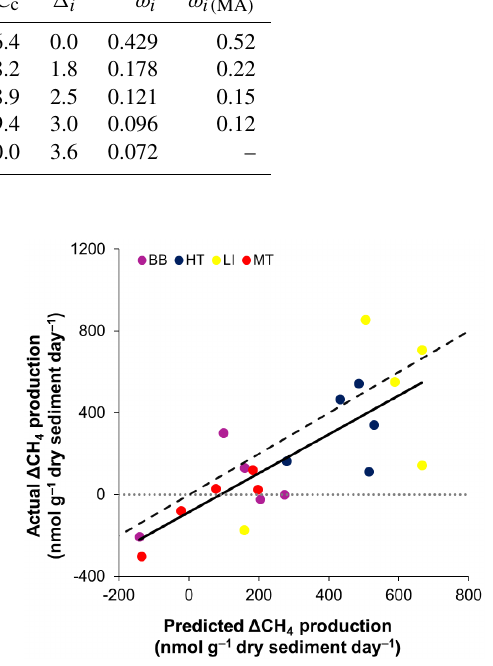
Figure 6. Actual response of (cid:49) CH 4 production (treatment mi- nus control; nmolg − 1 dry sedimentday − 1 ) plotted against the pre- dicted response from model-averaged parameter estimates of the macrophyte species added (BB is buckbean Menyanthes trifoliata , HT is horsetail Equisetum variegatum , LI is lily Nuphar polysepa- lum , and MT is marestail Hippuris vulgaris ), porewater acetate availability, and total sulfate availability. The dashed black line de- picts the 1:1 line, and above the gray dotted line marks the point at which adding organic matter increased CH 4 production (or (cid:49) CH 4 production > 0). The solid black line is the best-fit line between the actual and the predicted responses ( y = 0 . 95 x − 86; r 2 of 0.59), which demonstrates that although the model did a decent job of pre- dicting relative changes in the response, it tended to underestimate (cid:49) CH 4